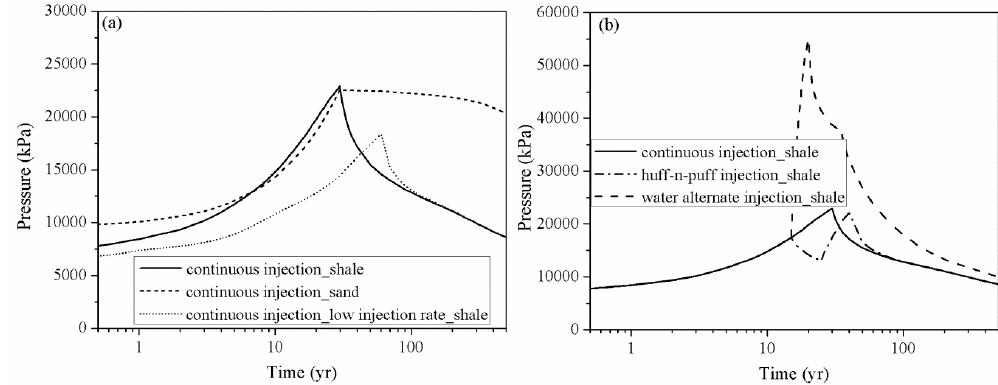
Figure 9. Pressure evolution at observation point # 1 (X = 275 m, Y = 375 m) for different cases.( a ) compares the pressure perturbation of continuous injection scenario of shale and sand and also the influence of injection rate; ( b ) shows the pressure build-up of continuous injection scenario, huff-n-puff injection scenario and water alternate injection scenario of shale reservoir).